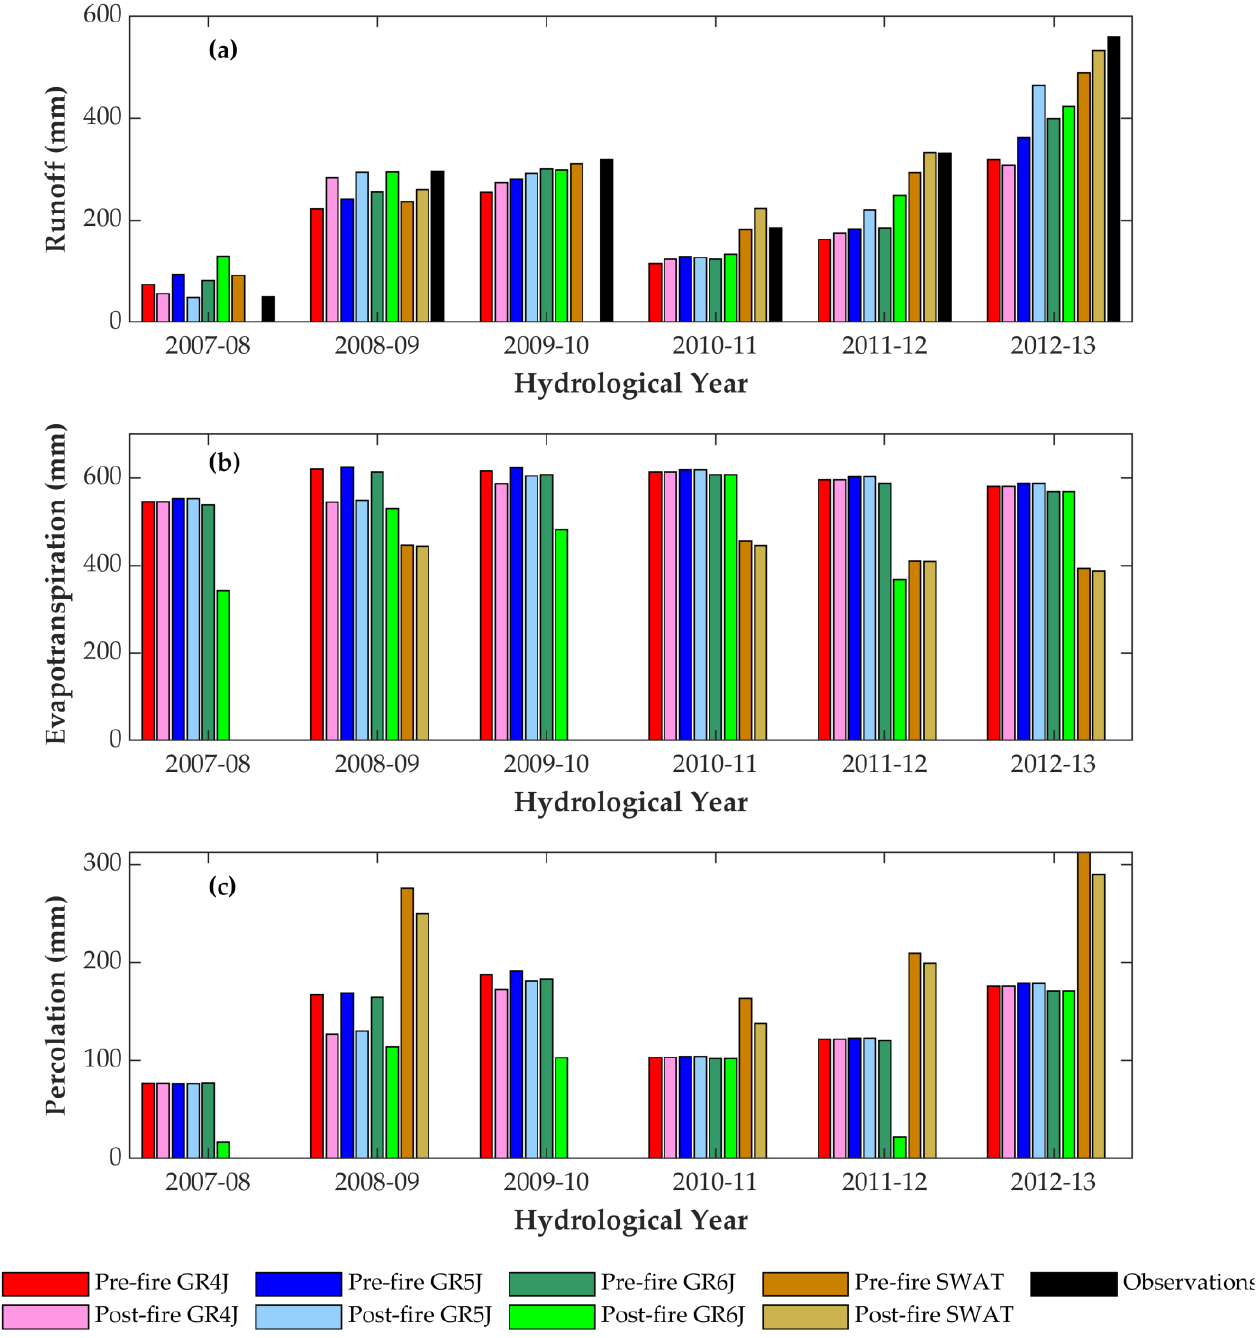
Figure 5. Simulated annual volumes for: ( a ) runoff; ( b ) evapotranspiration; ( c ) estimated percolation using parameters from the pre-fire period and parameters from the post-fire data on a year-by-year basis (constrained X1 for GR models).